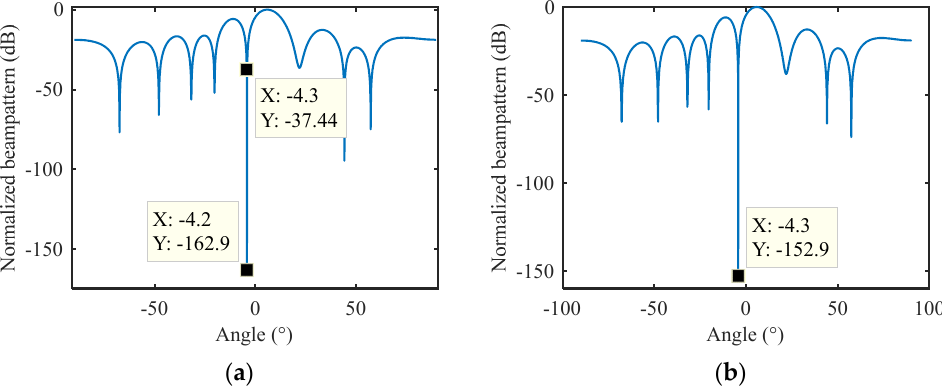
Figure 15. Transmit beampattern synthesized using ( a ) sensed and ( b ) predicted interference knowledge.